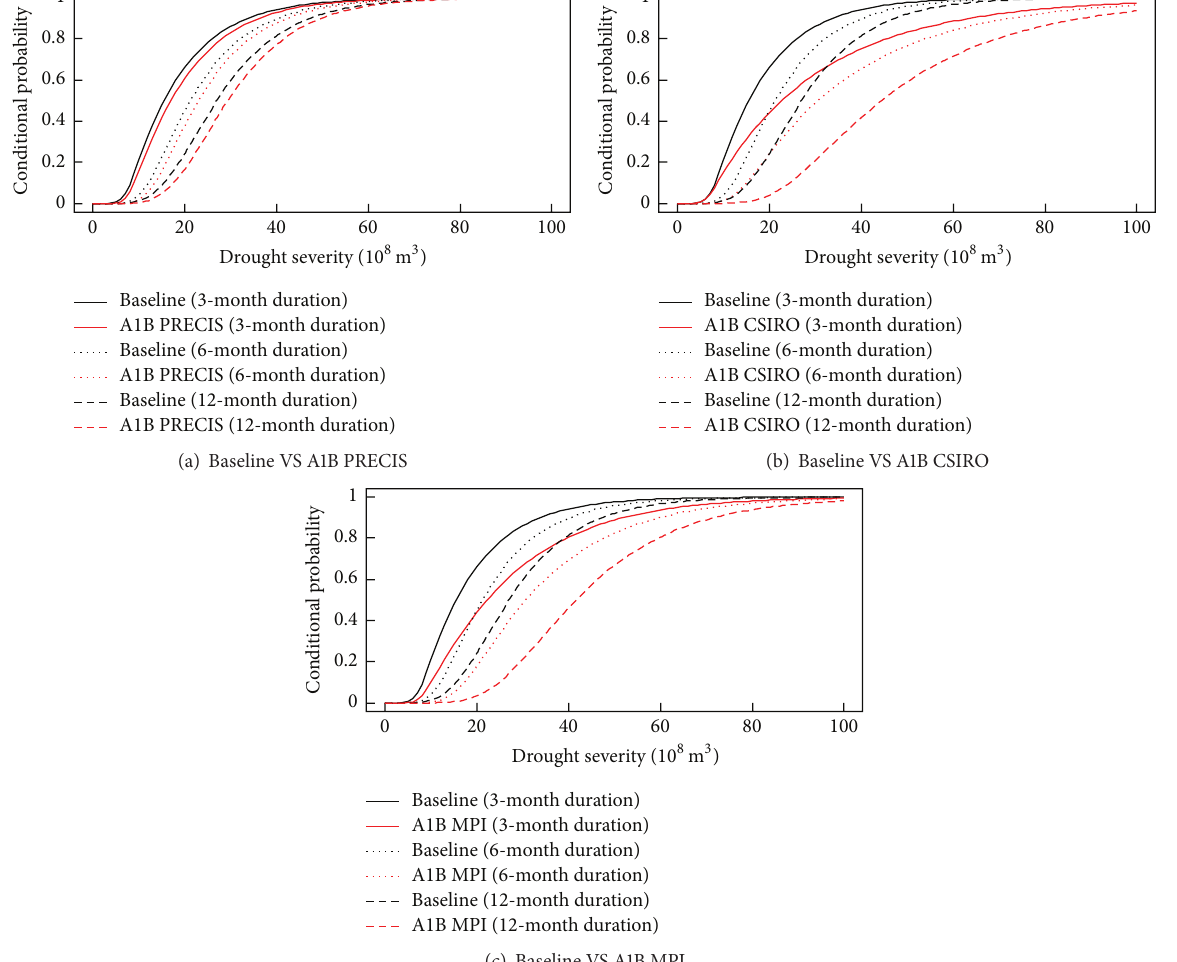
Figure 9: Conditional probability of drought severity distributions with given durations of 3, 6, and 12 months under baseline and three A1B